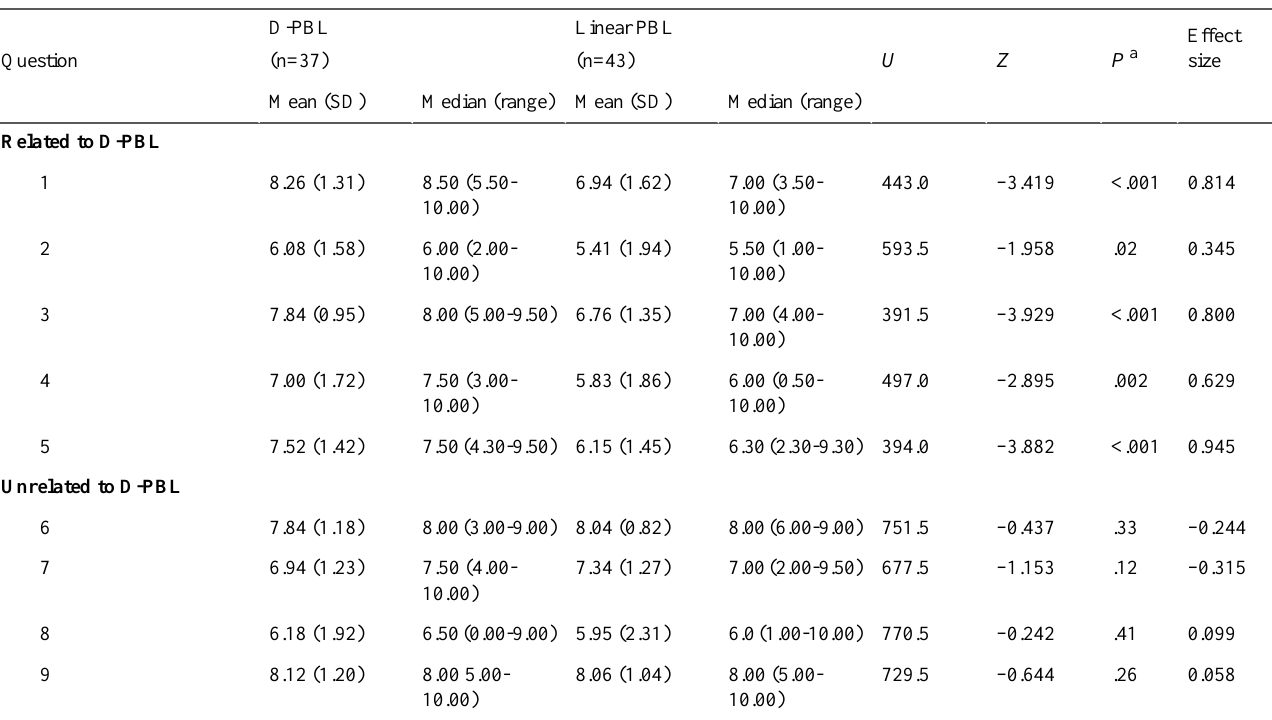
Table 2. Exam question results